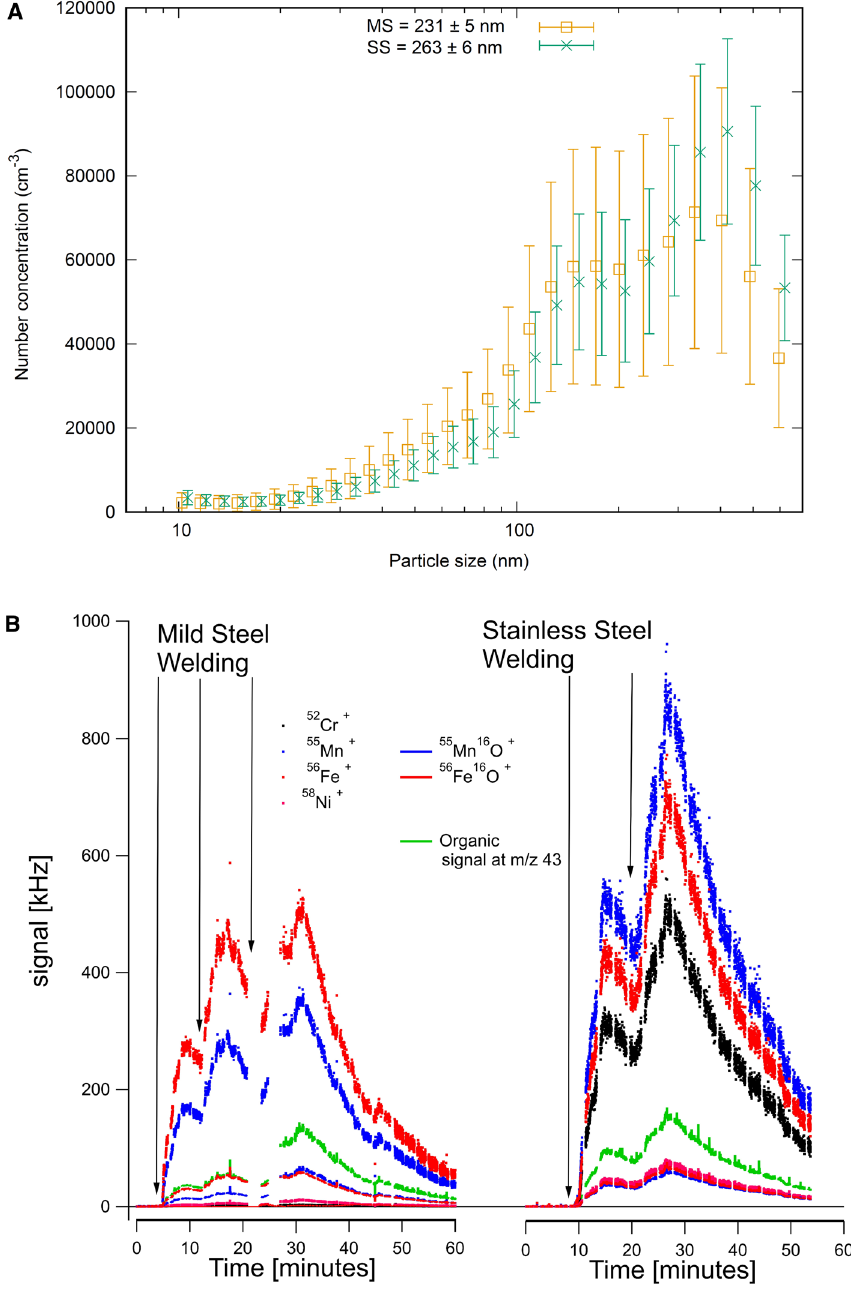
Figure 1. Characterization of welding particles during generation. ( A ) The particle number concentration and mobility size distribution (10–650 nm) were measured using a Scanning Mobility Particle Sizer (SMPS) system. The error bars indicate that welding was not done continuously throughout the sampling period, but in intervals. ( B ) An example of aerosol mass spectrometry spectra. Time resolved aerosol mass spectrometry data showing signal intensity for selected metal and metal oxide ions, and organic signal at m/z 43 (corresponding to 9–11% of total organic signal). Black vertical arrows indicate welding. Figures were created using gnuplot version 5.2 ( A ) and IGOR pro 6.37 ( B